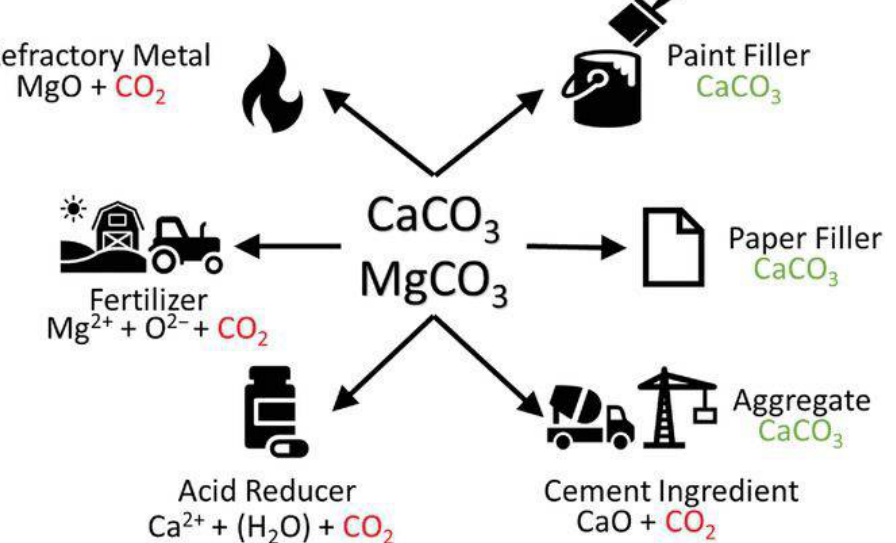
Figure 15. Current industrial uses of carbonate minerals and their final chemical form. From Reference [224].